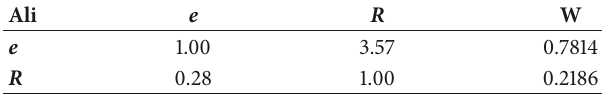
Table 9: Comparison for grade length node.